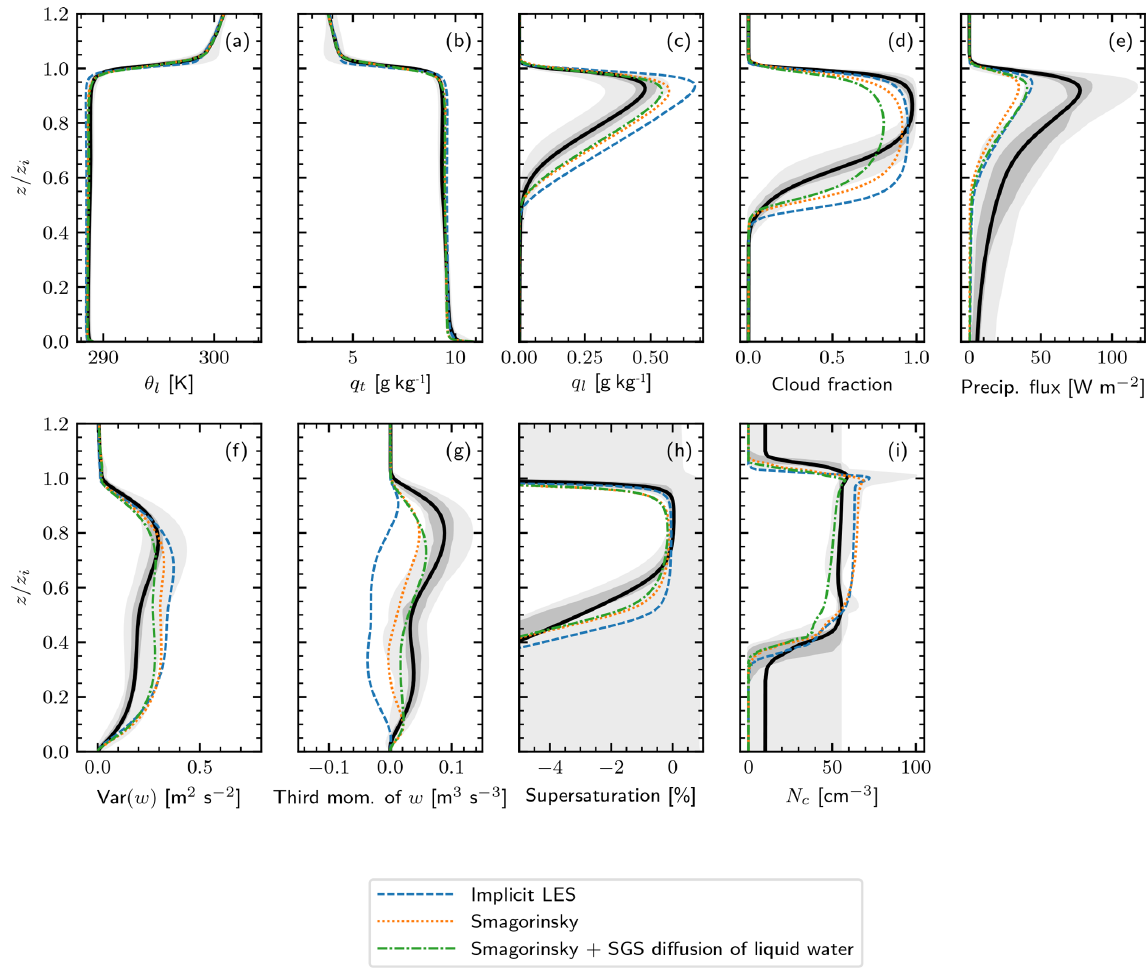
Figure 6. As in Fig. 4, but for the 3-D UWLCM simulations. No averaging over ensembles is carried out, i.e., each line comes from a single UWLCM